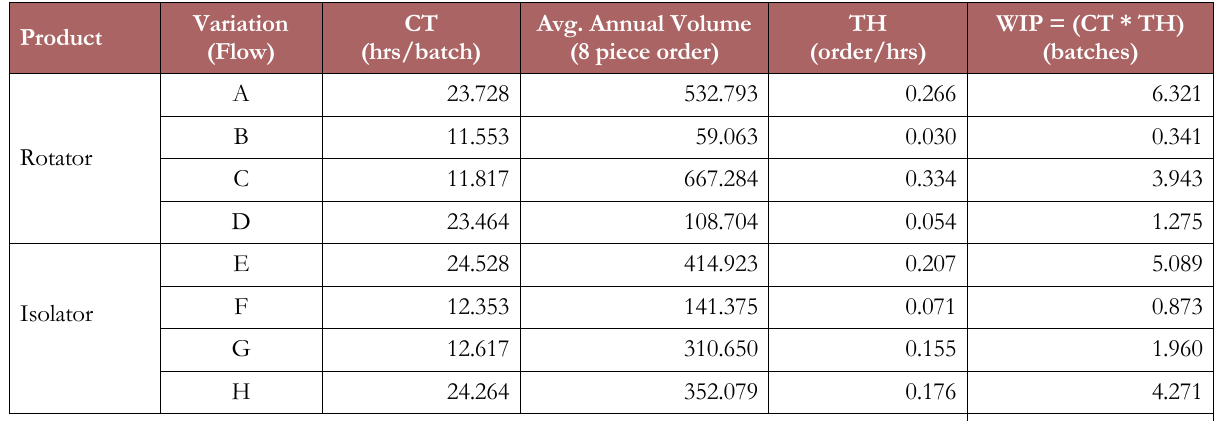
Table 3. Minimum WIP Level